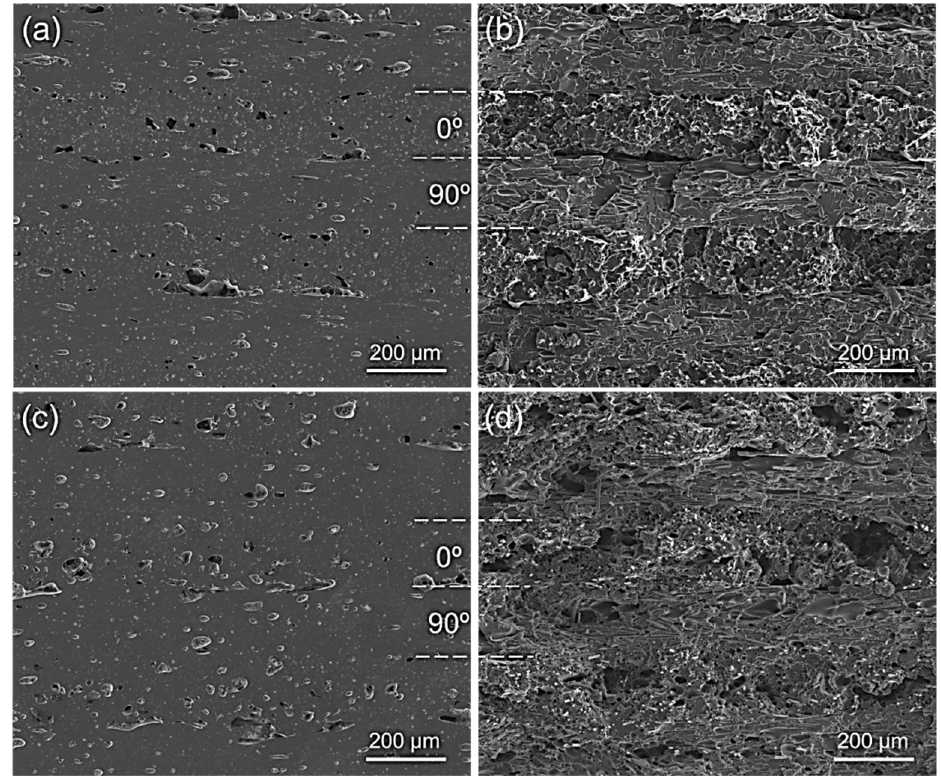
Figure 21. Cross sections prior to mechanical testing and their respective fracture surfaces of speci- mens printed at different printing bed temperatures. ( a ) 100 °C before mechanical testing (C13); ( b ) printed at different printing bed temperatures. ( a ) 100 ◦ C before mechanical testing (C13); ( b ) 100 ◦ C 100 °C after mechanical testing; ( c ) 120 °C before mechanical testing (C14); ( d ) 120 °C after mechan- after mechanical testing; ( c ) 120 ◦ C before mechanical testing (C14); ( d ) 120 ◦ C after mechanical ical testing.